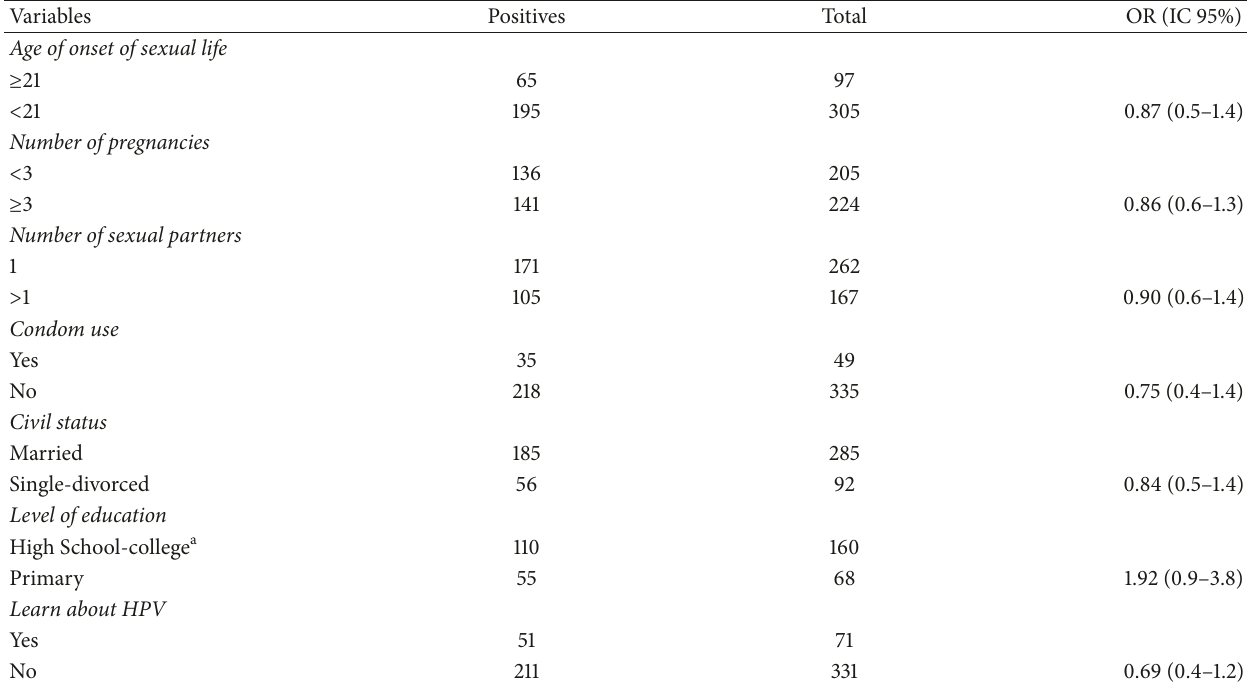
Table 4: Risk factors and HPV